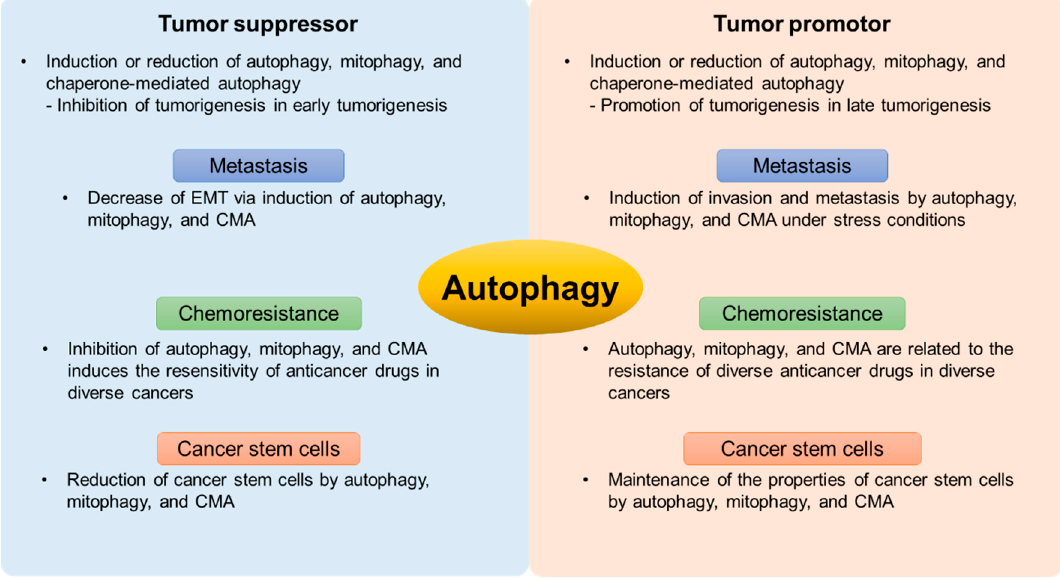
Figure 2. Schematic diagram of the autophagic roles of tumor promotion and suppression in cancer cells.